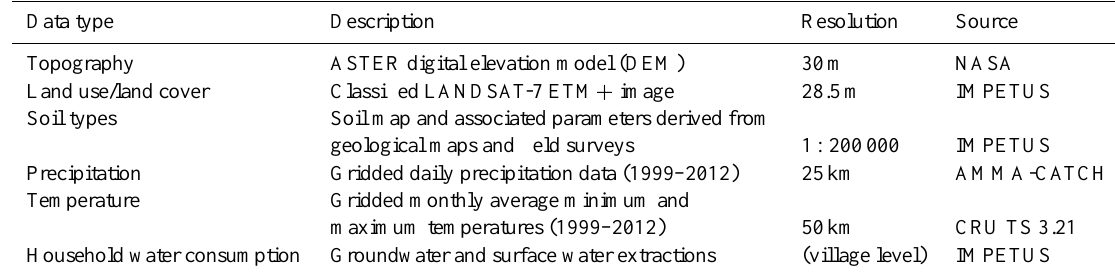
Table 1. Description of spatial input data of the Upper Ouémé watershed for the SWAT Landscape